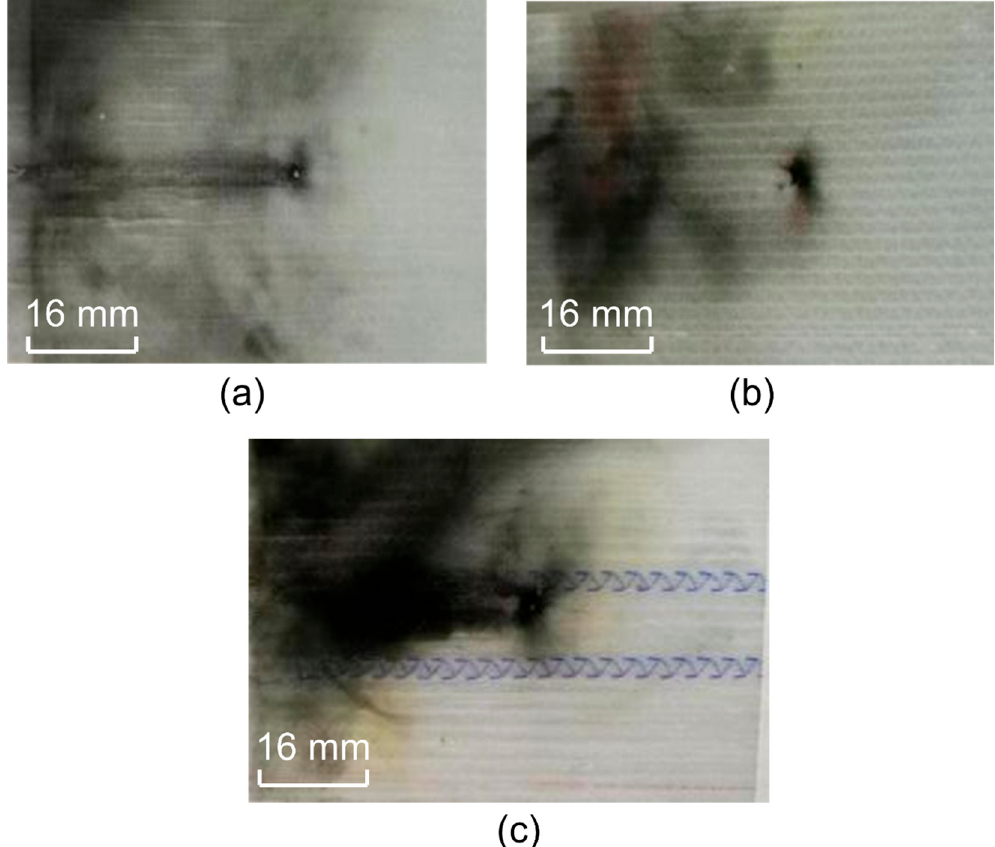
Figure 9. Damage morphology of GFRC laminates under different lightning current components, ( a ) component A, ( b ) component B, ( c ) component